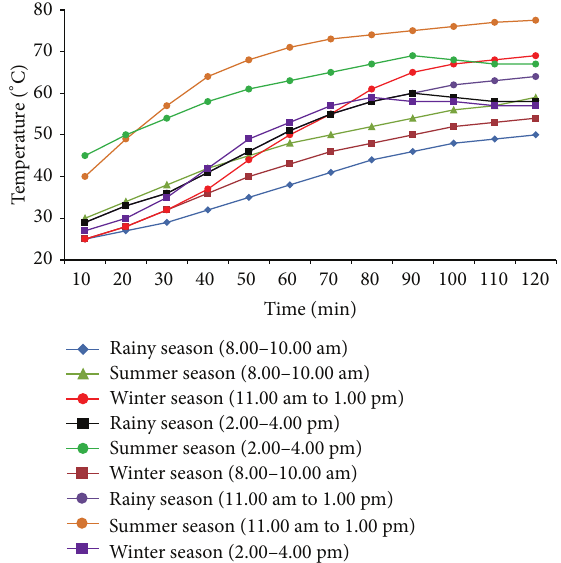
Figure 3: Response of outlet hot water temperatures in different seasons.